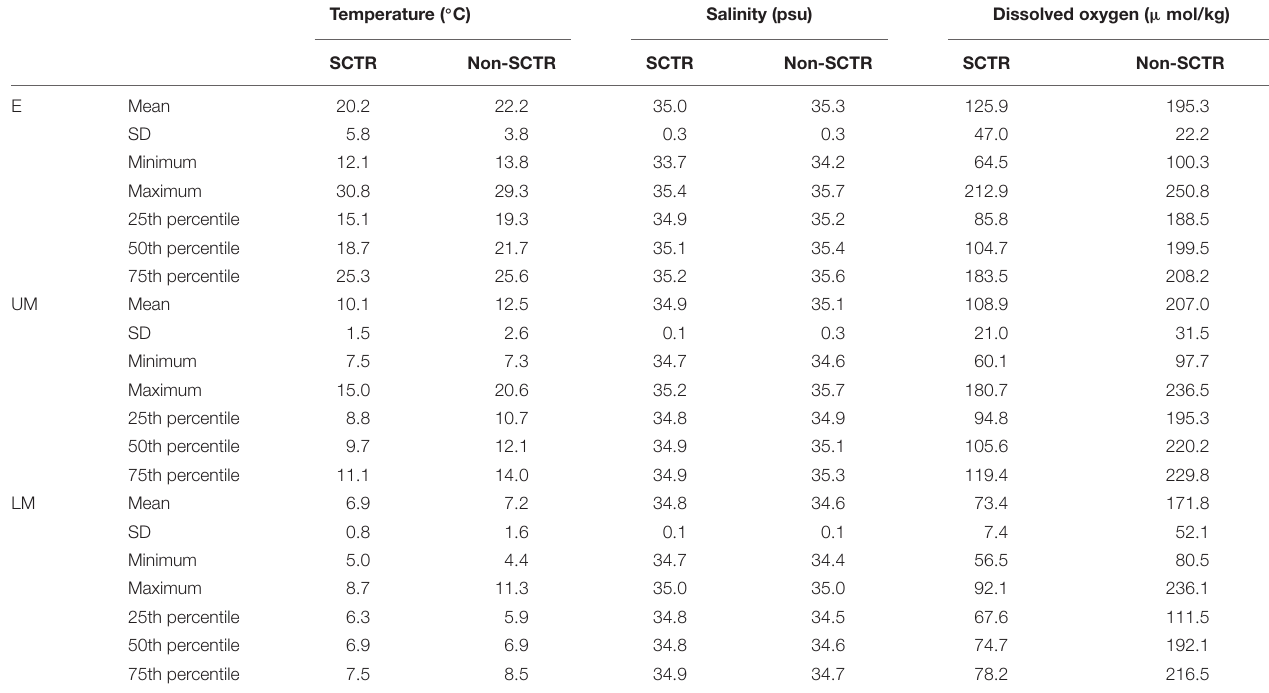
TABLE 3 | The marine environmental properties in the depth layers between the SCTR and non-SCTR. Temperature ( ◦ C) Salinity